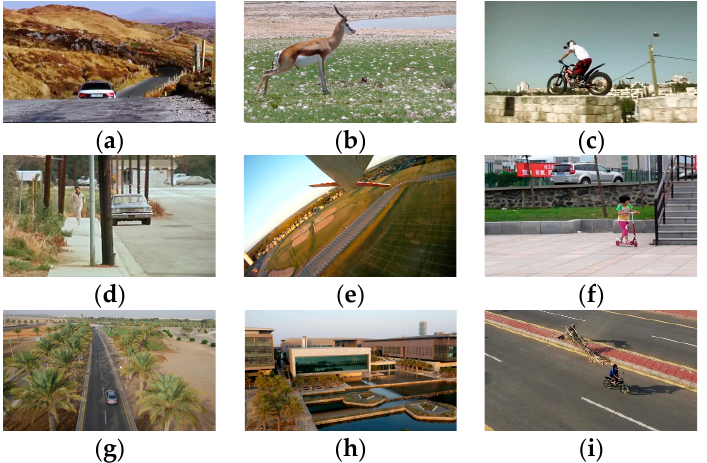
Figure 4. Sample images of the experiment